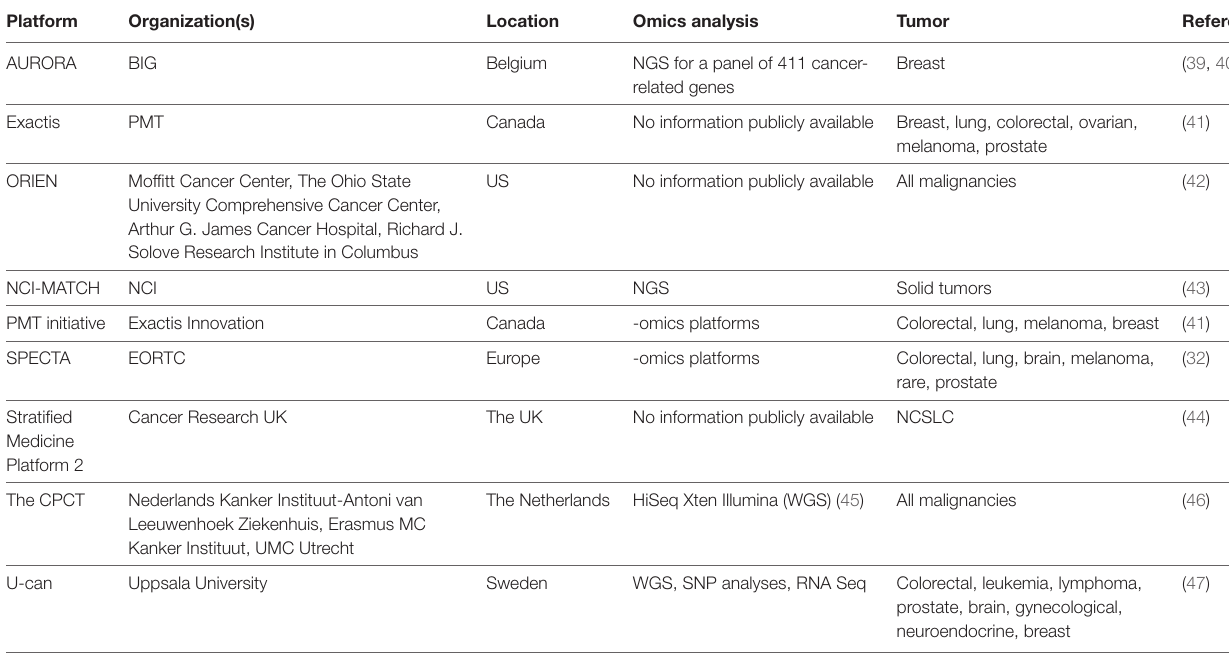
Table 3 | Non-exhaustive overview of prospective, collaborative -omics screening platforms to facilitate clinical research in precision oncology.